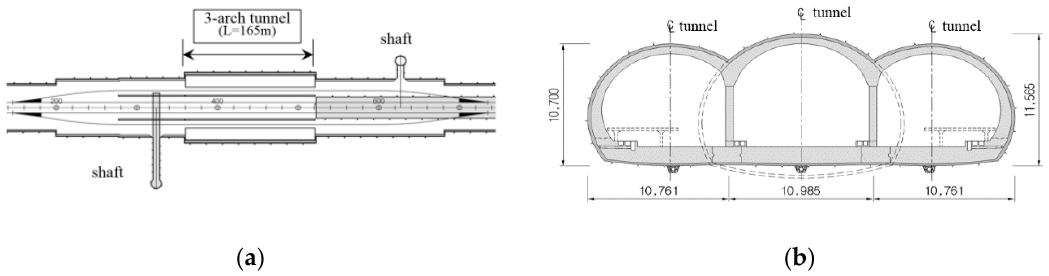
Figure 5. Three-arch tunnel: ( a ) air view ( b ) cross-sectional view.